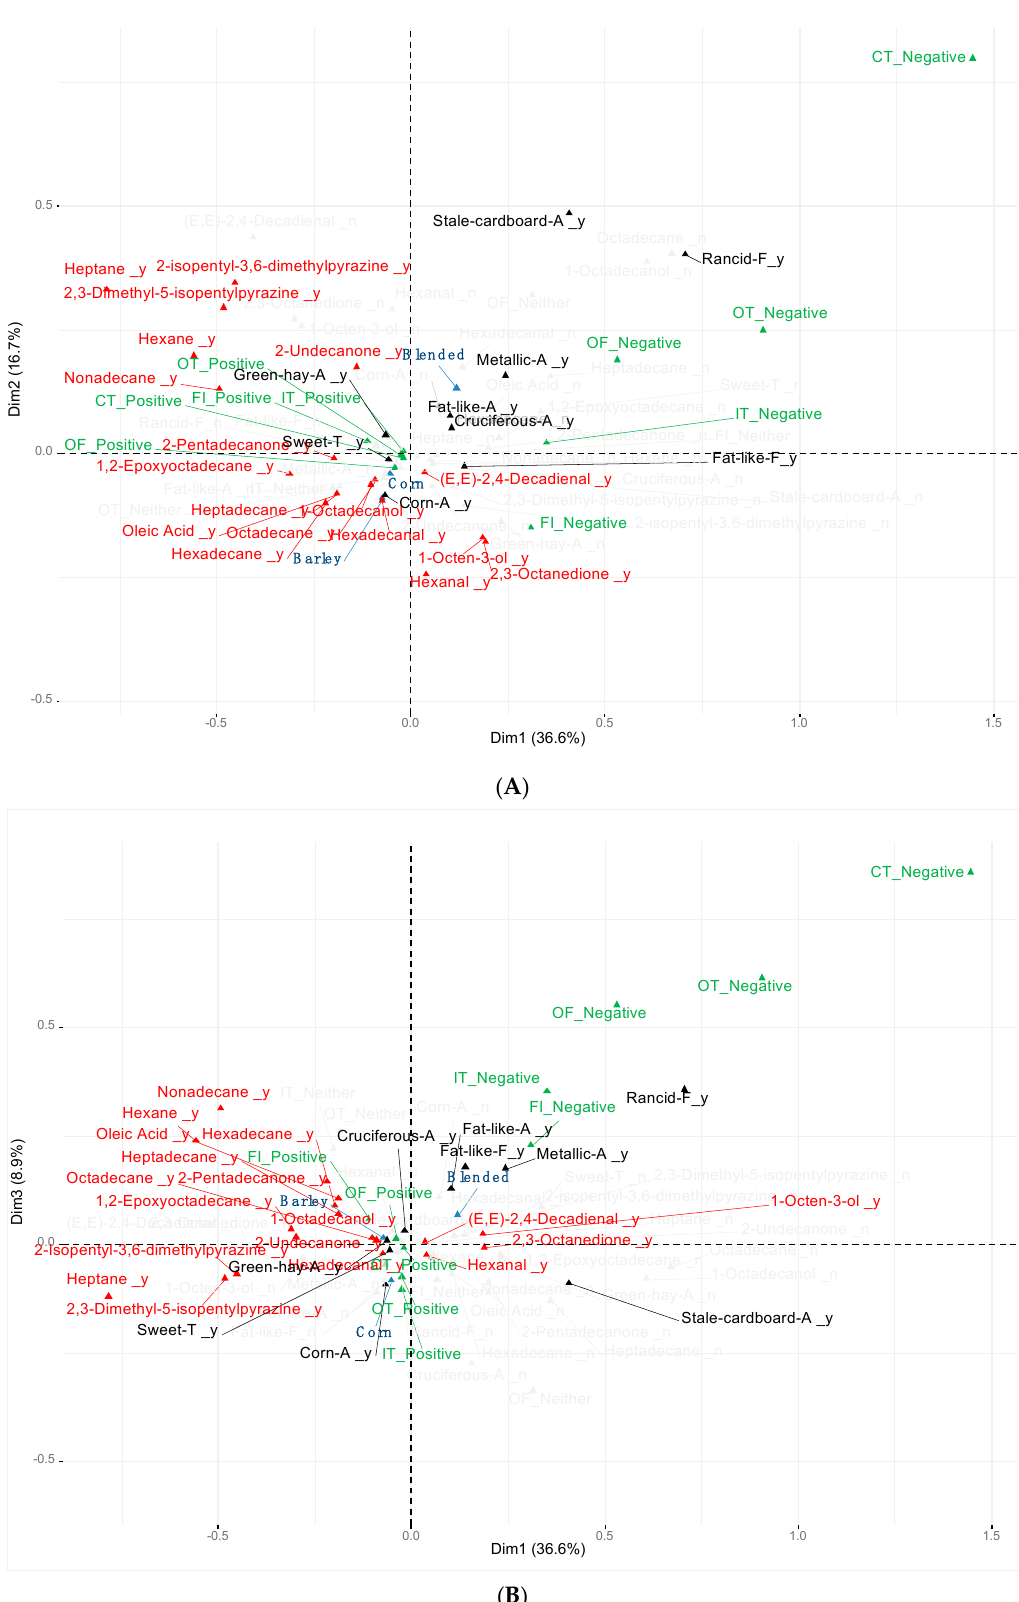
Figure 1. Multiple correspondence analysis among descriptive sensory attributes, flavor profile, and volatile compounds from barley, corn, and blended grain-fed beef. Blue: grain diet; red: volatile compounds; black: aroma/taste/flavor descriptors; green: descriptive sensory attributes. ( A ) Dimensions 1 and 2. ( B ) Dimensions 1 and